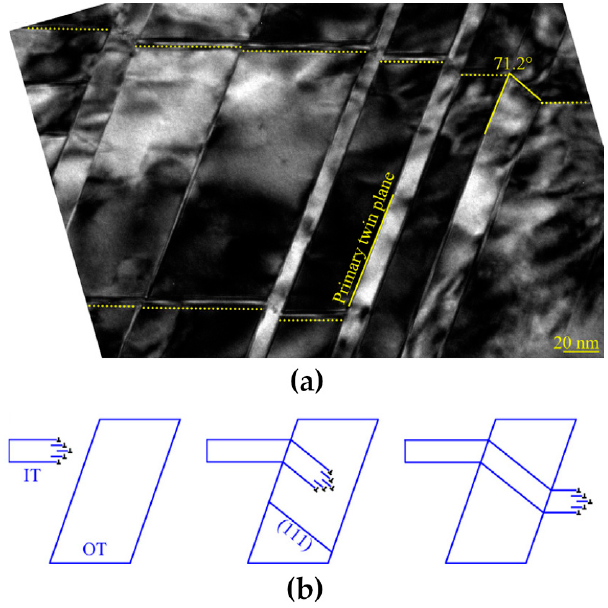
Figure 26. The ordinary twin transmission across twin boundaries in bcc and fcc metals. ( a ) The TEM image; ( b ) The schematic illustration showing the process of twin intersection. (Reprinted from Reference [39], with permission from Elsevier).